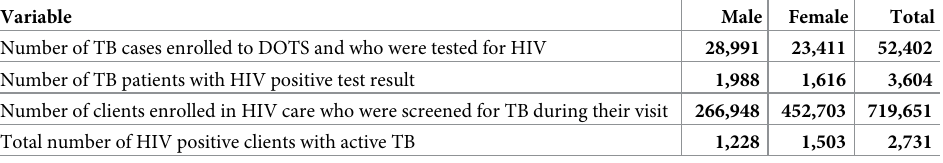
Table 1. The number of TB, HIV and TB/HIV co-infected patients reported in Ethiopia by gender in